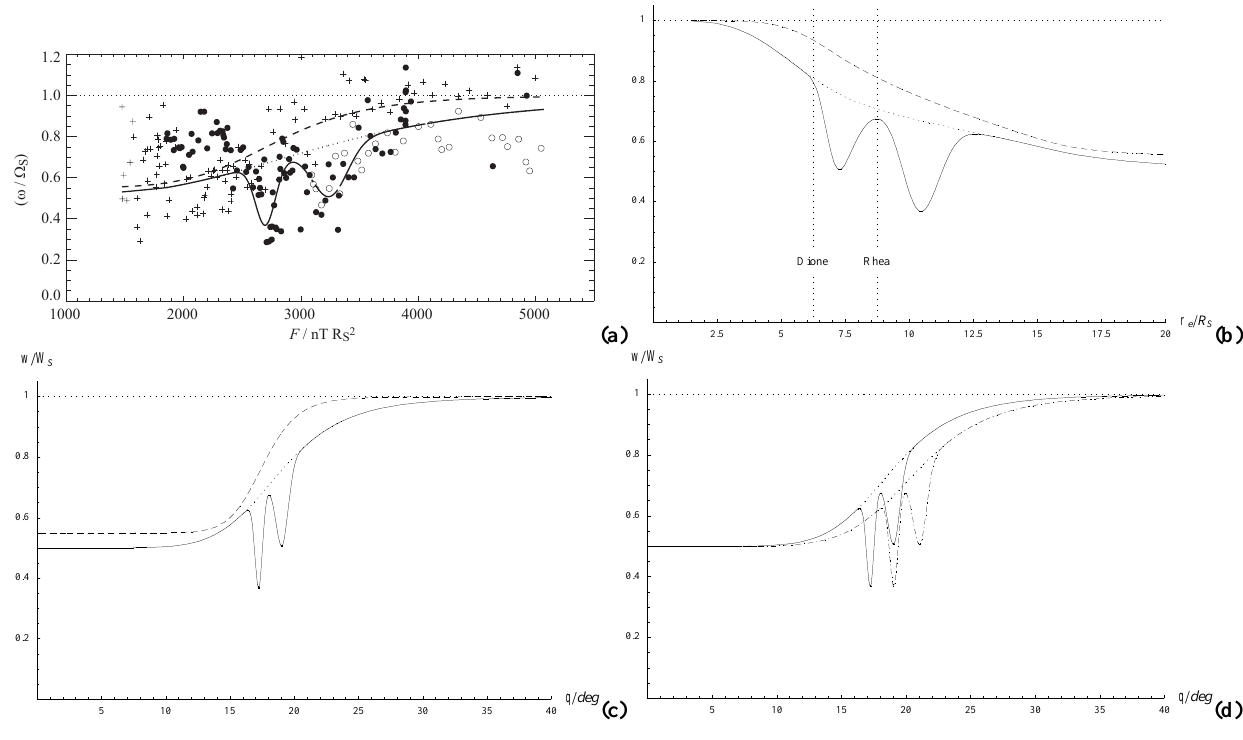
Fig. 4. (a) Plasma angular velocity values (normalised to Saturn’s angular velocity (cid:127) S ) determined from Voyager PLS data, are shown plotted versus the magnetic field flux function F evaluated along the spacecraft trajectories. The model magnetic field is given by the sum of the internal planetary field given by Eq. (1), and the Connerney et al. (1983) ring current model determined from fits to the Voyager magnetic field data, given by Eq. (2). Solid and open circles show data from the inbound and outbound passes of Voyagers-1 and -2, respectively, while crosses show data from the inbound pass of Voyager-2. The curves show model fits to these data. The dashed curve shows a fit to the Voyager-2 data using Eq. (25) alone, with (ω/(cid:127) S ) ∞ = 0 . 55, F o = 2800nT R 2 , and n = 7. The solid curve shows a fit to the S Voyager-1 profile using Eq. (25) with (ω/(cid:127) S ) ∞ = 0 . 5, F o = 3200nT R 2 , and n = 4, together with Eq. (26) with two terms given by S (1ω/(cid:127) S ) 1 = 0 . 25, F 1 = 3250nT R 2 , and 1F 1 = 210nT R 2 , and (1ω/(cid:127) S ) 2 = 0 . 3, F 2 = 2700nT R 2 , and 1F 2 = 120nT R 2 . The S S S S dotted curve shows the Voyager-1 profile with the small-scale features omitted, given by Eq. (25) alone. The horizontal dotted line shows the condition for rigid corotation of the plasma, (ω/(cid:127) S ) = 1. (b) Plot of the model (ω/(cid:127) S ) profiles mapped along field lines into the equatorial plane and shown as a function of radial distance ρ e from the planet, normalised to the conventional Saturn radius R S . The line format is the same as in (a). The radial distances of the orbits of the moons Dione and Rhea are indicated by the vertical dotted lines, showing their relationship to the ‘dips’ in the Voyager-1 profile. (c) Corresponding profiles in the Northern Hemisphere plotted versus co-latitude θ , using the same line format as (a) and (b). (d) Comparison of Voyager-1 (ω/(cid:127) S ) profiles in the Northern (solid and dotted curves) and Southern (dot-dashed and dotted curves)